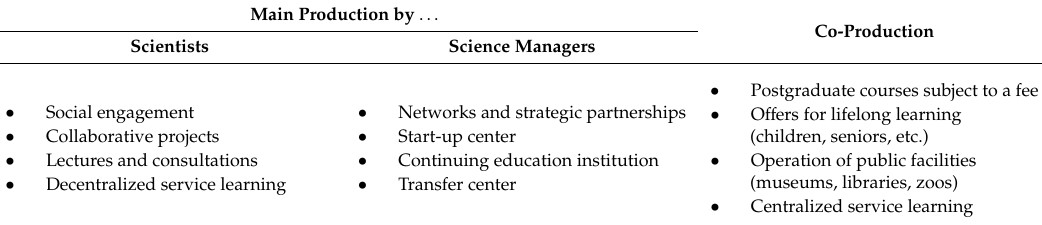
Table 1. Operative actors of various Third Mission activities. Main Production by